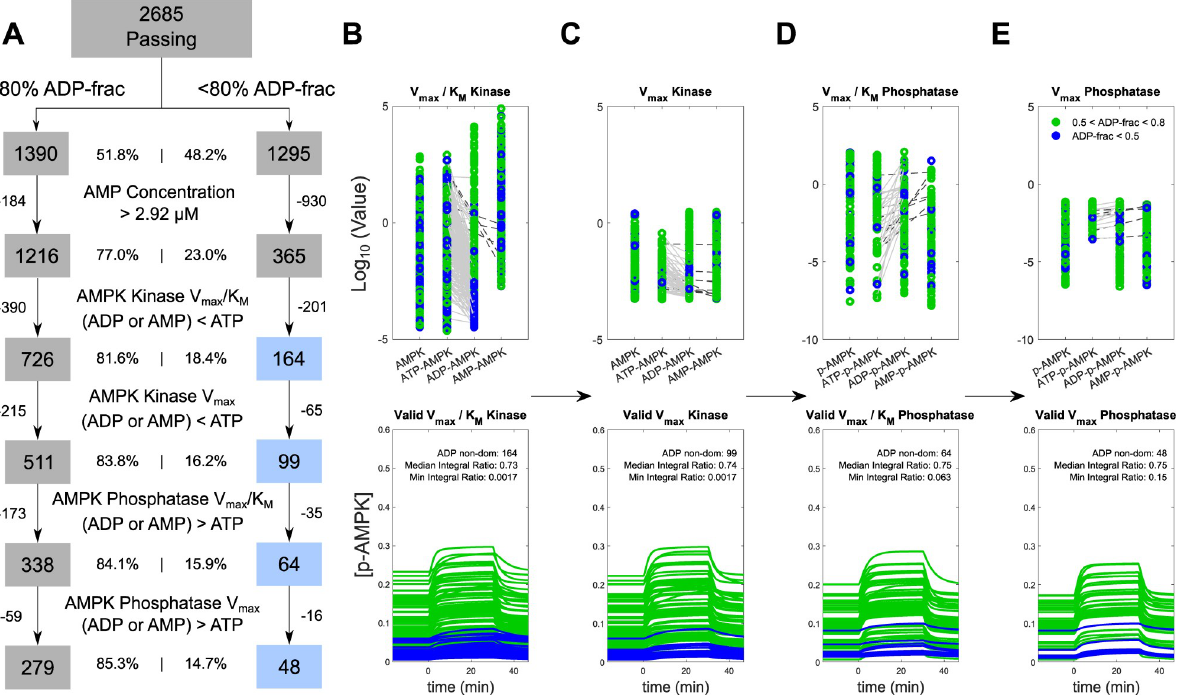
Fig 4. Evaluation of model plausibilities from the α 2 β 2 γ 3K D MPSA against data-informed constraints. A) Workflow of the progressive elimination of implausible models. After partitioning out the simulations into ADP-dominant (left boxes, > 80% ADP-frac) or ADP non-dominant cases (right boxes, < 80% ADP-frac), we then imposed data-informed constraints on the parameter values and ratios. The labels located in between the workflow boxes represent criteria for identifying models as implausible. B-E) The panels from left to right show the progressive elimination of implausible models from the simulations in the α 2 β 2 γ 3K D MPSA in which ADP-p-AMPK contributed less than 0.8 of the time integral of AMPK activity. The panels from left to right correspond to the models featured in the blue-shaded boxes from top to bottom in panel A. Points and curves colored green or blue indicate simulations with fractions of ADP control that tend to either ADP- or AMP-dominant control, respectively. The upper panels display the log 10 values of the quantities shown in the top label of each plot for the labelled AMPK complexes below each plot. The green and blue points indicate values from models exhibiting ADP- and AMP-dominant control, respectively. The grey lines indicate implausible relative parameter values between ATP-p-AMPK and ADP-p-AMPK, whereas the black-hatched lines indicate implausible relative parameter values between ATP-p-AMPK and AMP-p-AMPK. which were subsequently eliminated. The lower panels represent the corresponding time courses of p-AMPK. The “Median Integral Ratio” and “Minimum Integral Ratio” correspond to the median and minimum values for the fractions of ADP control for the ensemble of models. B) First pass, simulations in which the V max /K M values of the kinase for ADP-AMPK and AMP-AMPK were lower than ATP-AMPK. C) Second pass, simulations in which the V max values of the kinase for ADP-AMPK and AMP-AMPK were lower than those for ATP-AMPK. D) Third pass, simulations in which the V max /K M of the phosphatase for ADP-p-AMPK and AMP-p-AMPK were higher than ATP-p- AMPK. E) Fourth pass, removing simulations in which the V max of the phosphatase for ADP-p-AMPK and AMP-p-AMPK were higher than ATP-p-